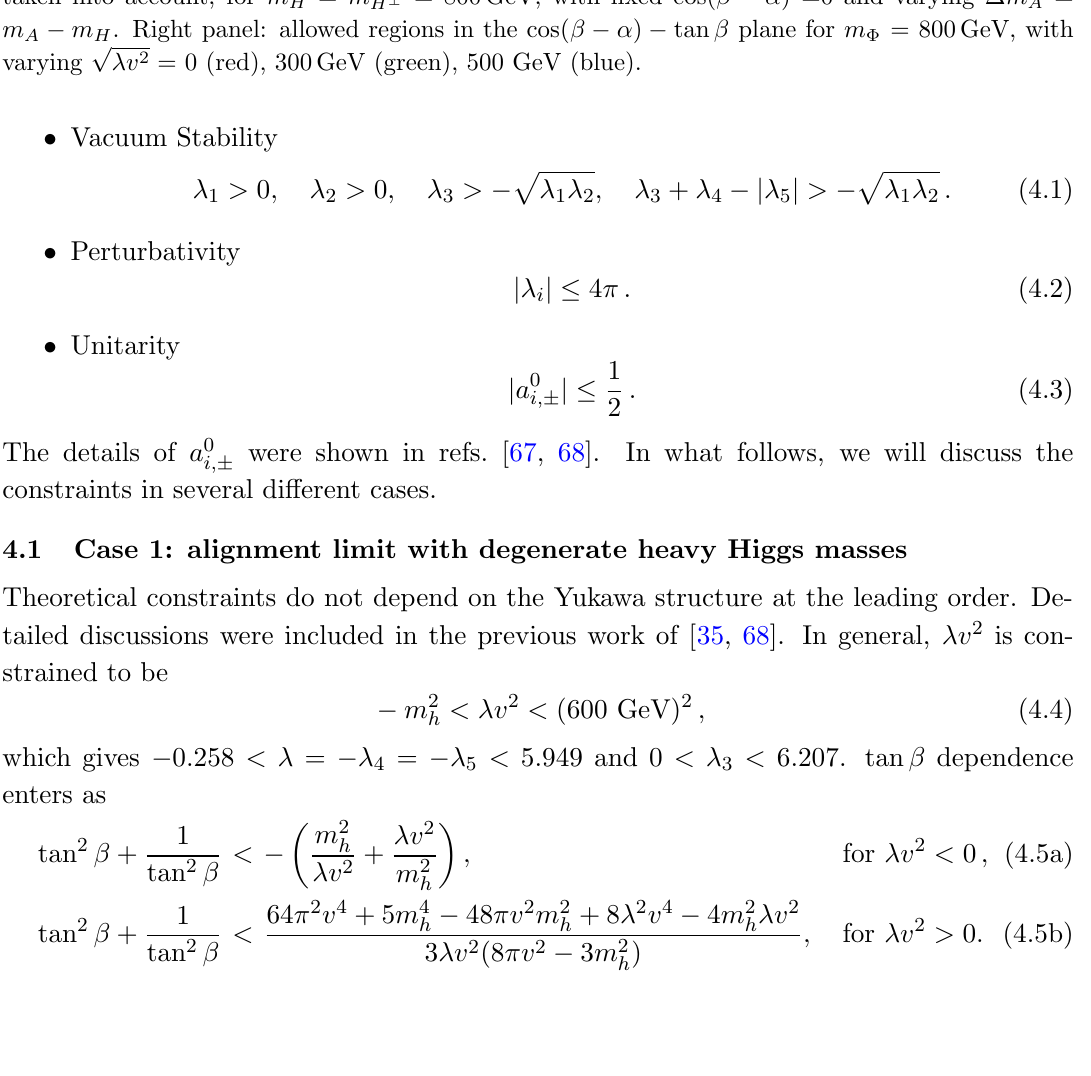
tan (cid:12) plane with all theoretical considerations (cid:0) (cid:11) ) =0 and varying (cid:1) m A = (cid:0) (cid:11) ) tan (cid:12) plane for m (cid:8) = 800 GeV, with (cid:0) (cid:0)